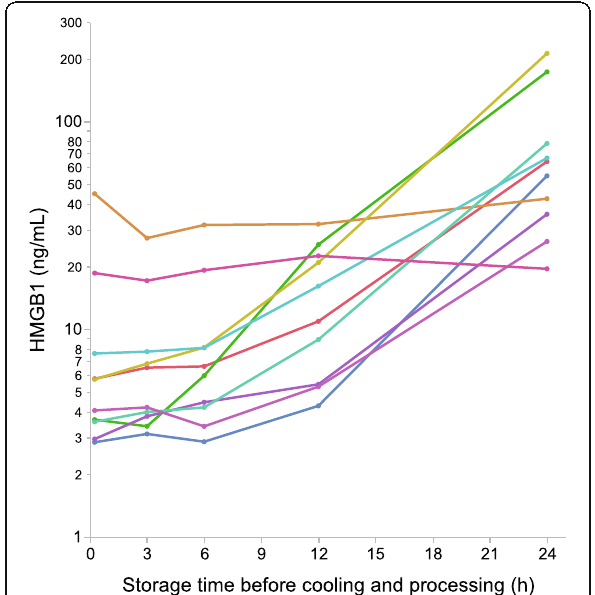
Fig. 1 Semilogarithmic plot of HMGB1 concentrations as a function of storage time in room temperature before centrifugation and freezing. Individual patients are color coded